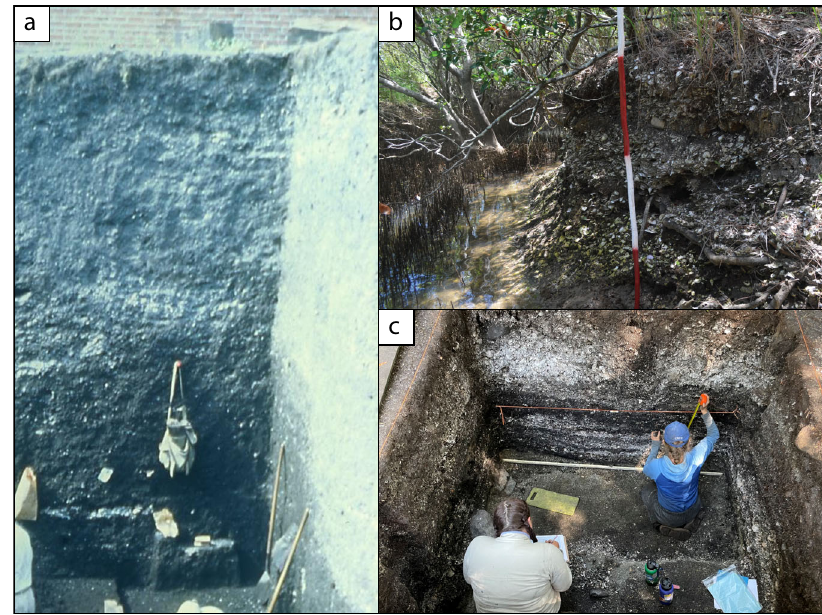
Fig. 5 Examples of archaeological sites, Paci fi c coast of North America and Australia. a Pro fi le of the West Berkeley Shell Mound, California exposed during excavation. This massive site dates from 6000 years ago through about 1100 years ago and is composed of oysters and other materials and also contains evidence for ceremonialism and ritual (Photo credit: Phoebe Hearst Museum of Anthropology, University of California Berkeley). b Bli Bli Midden, Southeast Queensland, showing dense shell fi sh concentrations, including oysters and dating to before 1850 (Photo credit: Kate Greenwood. Courtesy of the Kabi Kabi Peoples Aboriginal Corporation). c Dense shell midden deposit spanning the past 1000 years as exposed during excavation at a Tseshaht First Nation village in the Paci fi c Northwest (Photo credit: Iain